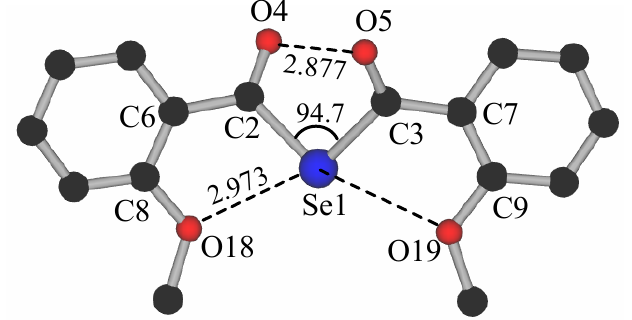
Figure 2. The optimized structure of (2-MeOC RHF/LANL-2dz level. Distances are in angstrom (Å) and angles (°). Torsion angles: O4- C2-C3-O5 = 63.5°; C2-Se1-O18-C8 = 24.2° in degrees (for the other distances and angles: see Table 3).